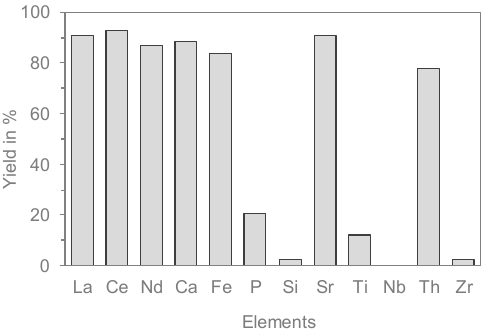
Figure 7. Yields of elements after digestion with caustic soda. The concentrate was mixed with a ratio of caustic soda to REO of 5 and baked for 4 h at 150 °C. After baking, the residue was leached with deionized water at a S:L ratio of 20 for 30 min at 80 °C. Then, the residue was leached in 6 M hydrochloric acid at a S:L ratio of 25 for 1 h at room temperature.